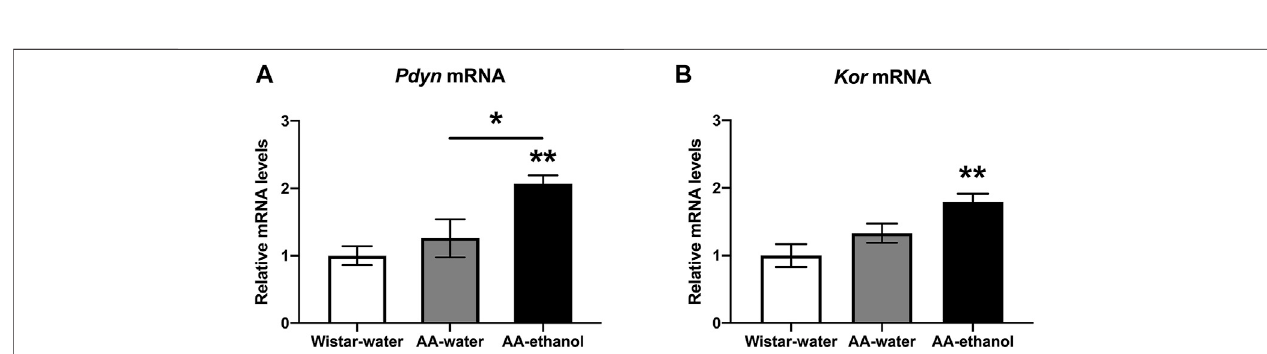
FIGURE 4 | Impact of intermittent alcohol exposure on Pdyn (A) Kor (B) expression levels in the NAc. One-way ANOVA followed by Tukey ’ s multiple comparisons test; ** p < 0.01, * p < 0.05 compared with the Wistar-water group; n (cid:2) 5 – 7. Error bars indicate SEM.